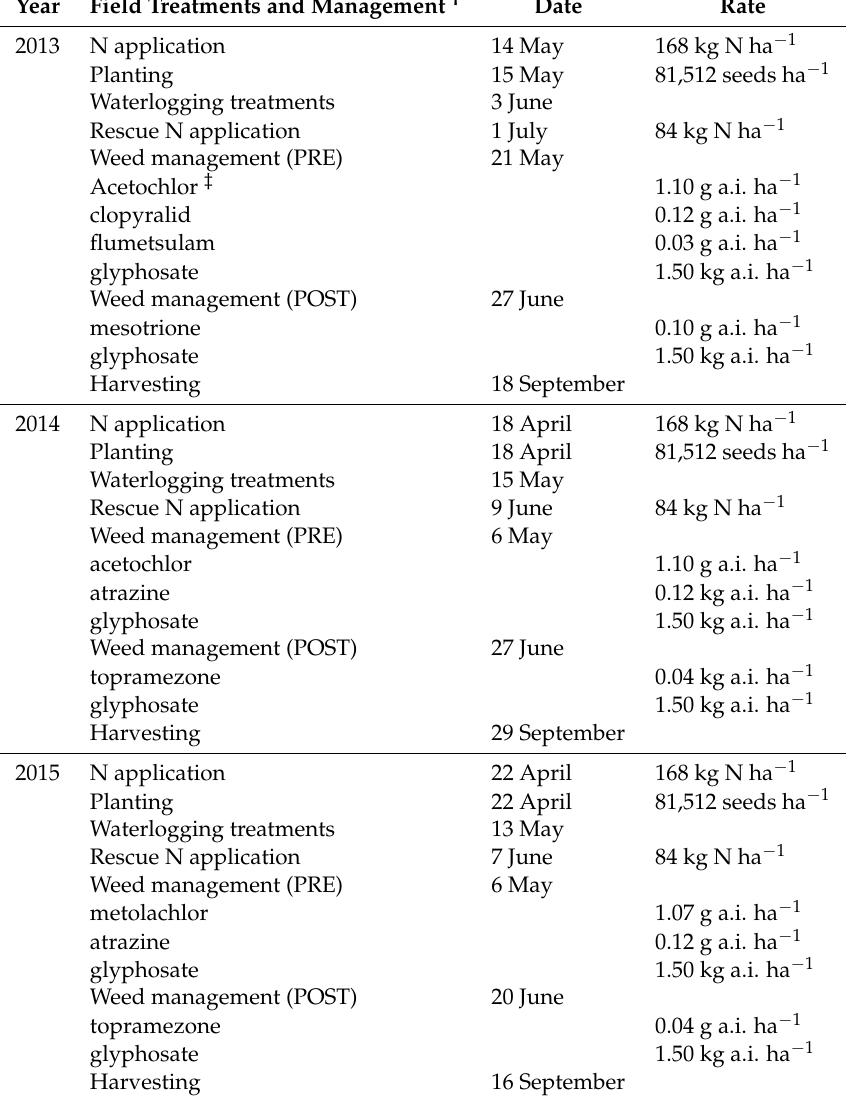
Abbreviations: PRE, pre-emergence; POST, post-emergence. † All crop protection products were applied with appropriate adjuvants and additives. ‡ Chemical name for herbicides: acetochlor [2-chloro-2 (cid:48) -methyl-6 (cid:48) -ethyl- N